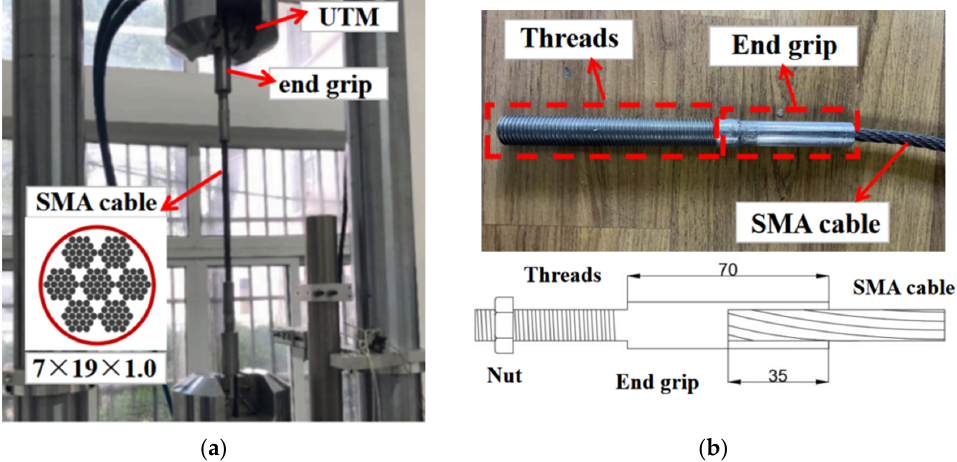
Figure 5. Information of SMA cable: ( a ) test setup and basic construction; ( b ) end grips. Pseudo-static tension testing of the SMA cable was conducted on a Universal Test Machine (UTM) to obtain their basic mechanical behavior. The displacement and the ap- plied load were monitored by the grip displacement and the built-in load cell in the UTM. A displacement-controlled incremental loading protocol was applied based on a displace- ment interval Δ 1 of 2.5 mm, which is equal to an axial deformation of 1% of the test cable sample. The loading began with three cycles each at Δ 1 , 2 Δ 1 , 3 Δ 1 , 4 Δ 1 , 5 Δ 1 , and 6 Δ 1 , as shown in Figure 6a.